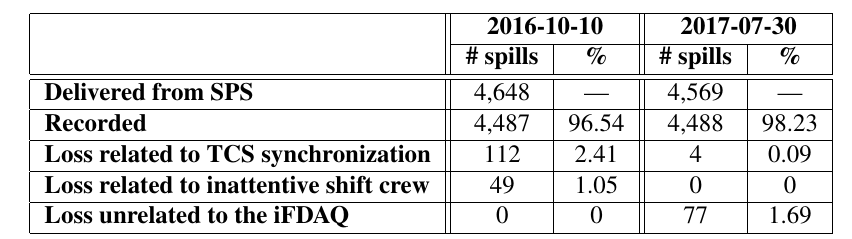
Table 1. The contribution of the continuously running